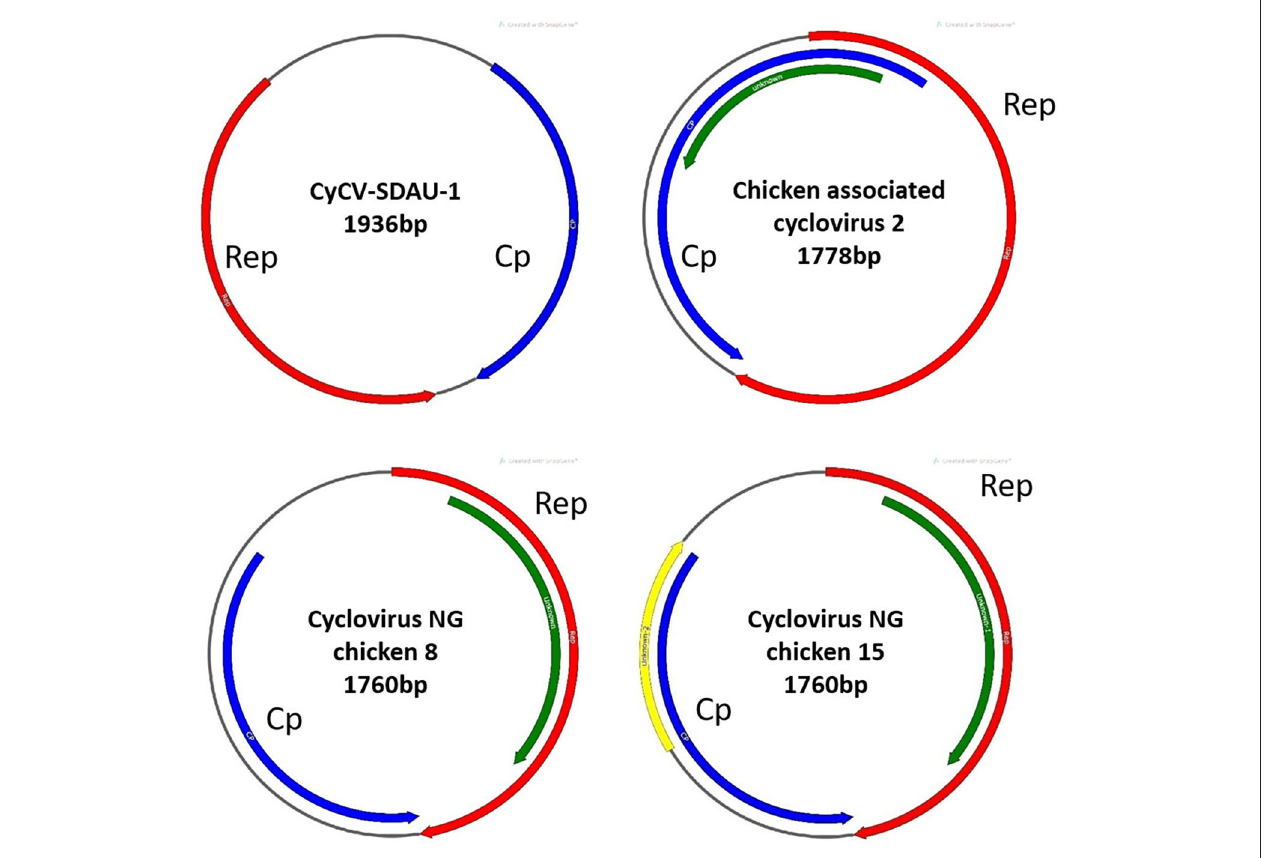
FIGURE 3 | Phylogenetic analysis of whole-genome sequences of the CyCV-SDAU-1 based on nucleotide sequences. The phylogenetic tree showed that CyCV-SDAU-1 may be the origin of other cycloviruses or some circoviruses. The phylogenetic analysis was performed using MEGA 6.0 using the neighbor-joining method with 1,000 bootstrap replicates. Scale bars are proportional to the genetic distance. Bootstrap values > 70% are shown at each node. Red and bold indicate the CyCV-SDAU-1